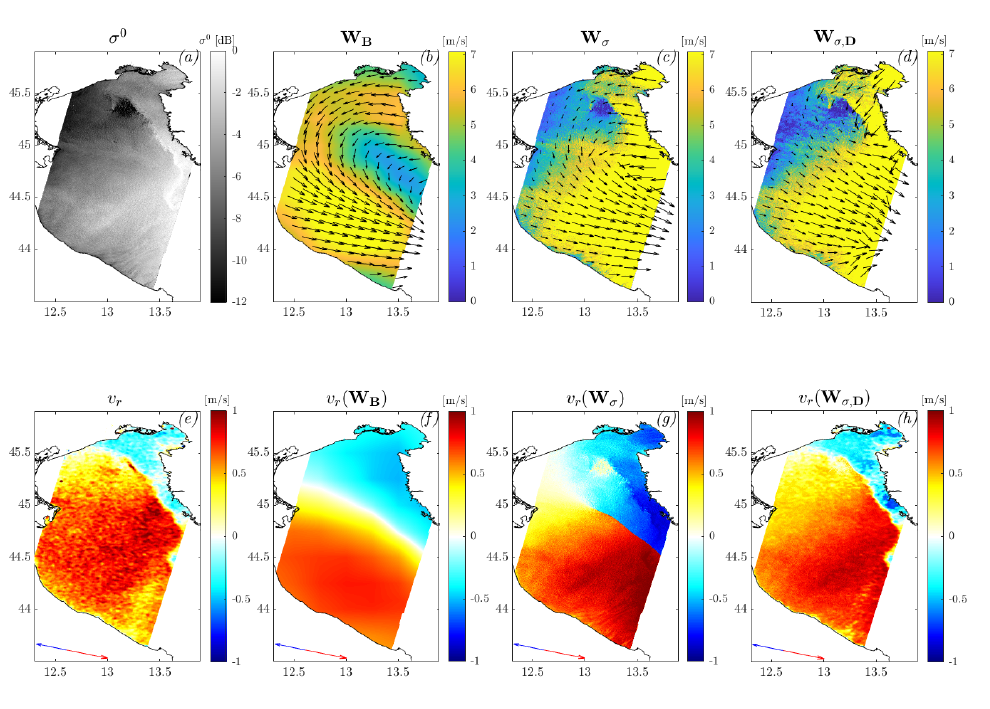
Figure 8. Results related to the descending acquisition of 3 November 2006. The panel composition follows the one in Figure